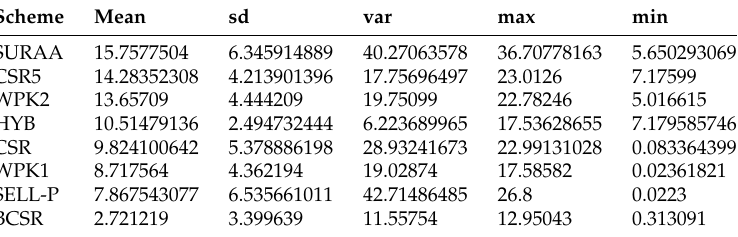
Table 4. Statistical information on the throughput in Giga Floating Point Operations per second (GFLOP/s) metric of the SpMV kernel for the 26 benchmark